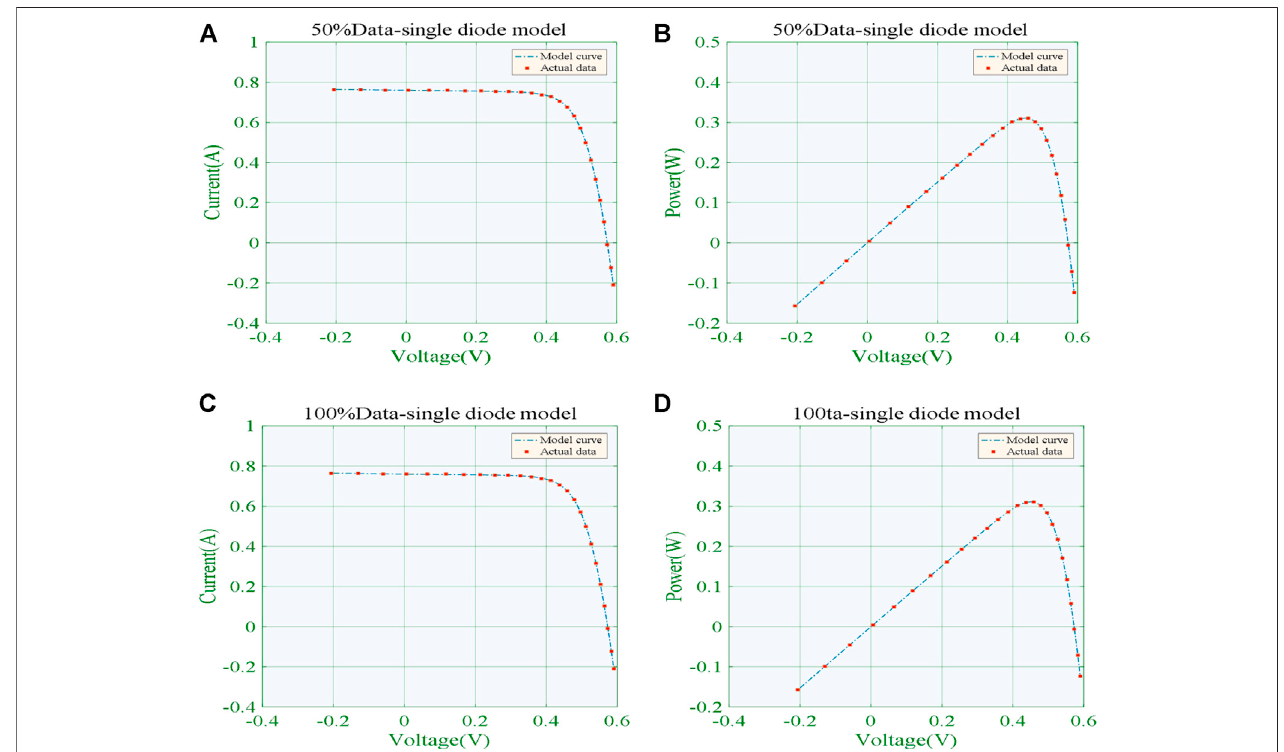
FIGURE 8 | Output curvesobtained by the best algorithm (GNN-WCA) for the SDM. (A) I-V curveunder 50% training data; (B) P-V curve under 50% training data; (C) I-V curve under 100% training data; (D) P-V curve under 100% training data.